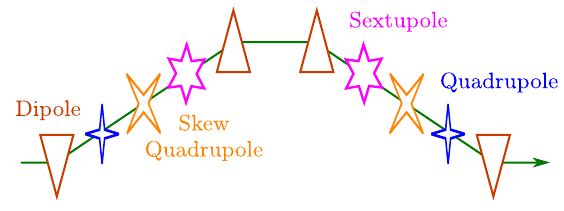
FIG. 2. Schematic drawing of the D -shape magnetic chicane. There are pairs of quadrupole, skew quadrupole and sextupole to correct for the